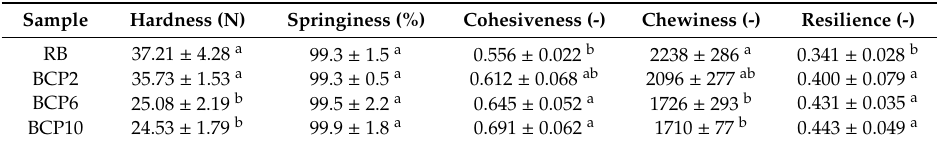
Table 4. Textural properties of